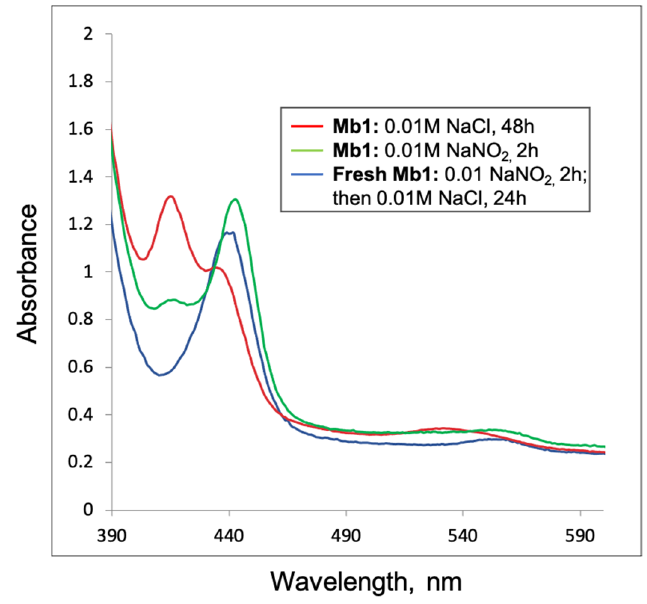
Figure 3. The UV-visible spectra evolution of membrane Mb1, plasticized with oNPOE and doped with 1 wt.% CoTPP-N (without any ion-exchanger sites’ addition), soaked first in 0.01 M aqueous solution of NaCl (red line) for 48 h and then in 0.01 M NaNO 2 (green line) for 2 h. For comparison, the UV-visible spectrum of fresh Mb1 soaked in 0.01 M NaNO 2 (blue line) for 2 h and then conditioned in 0.01 M NaCl for 24 h is also shown. Table 2. Kinetic parameters for the aggregation of CoTPP-N (5.0 × 10 -6 M) in the presence of NO 2- 241 ions. 242